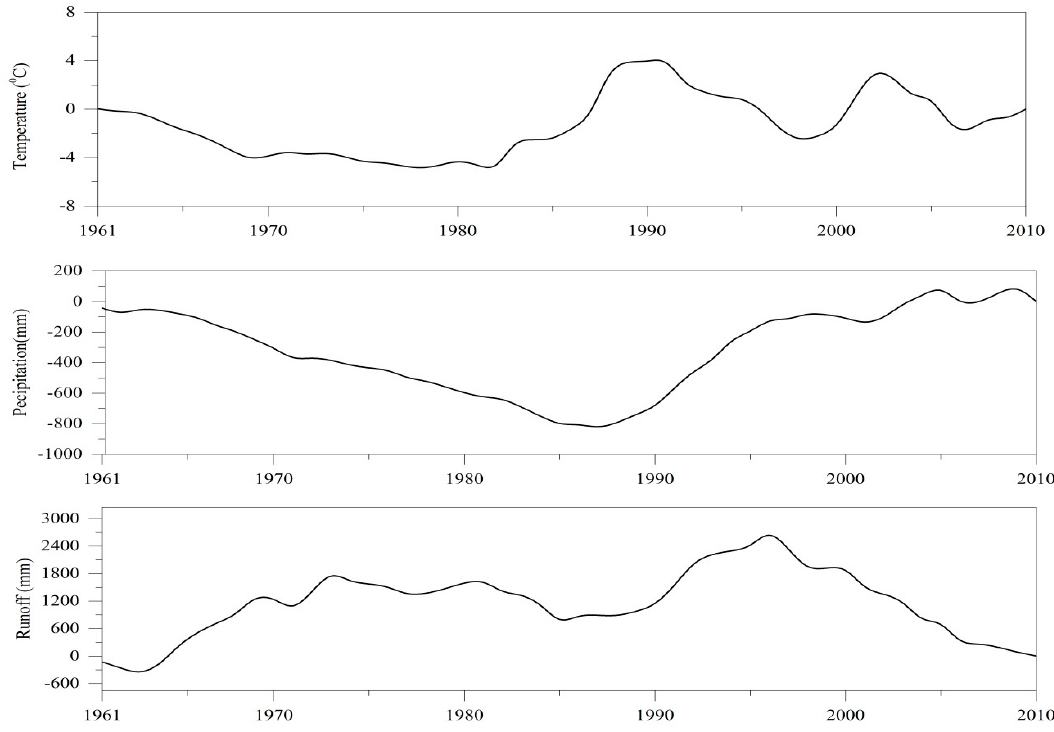
Figure 18. Accumulative deviation curve for runoff, precipitation and temperature for Zone I.